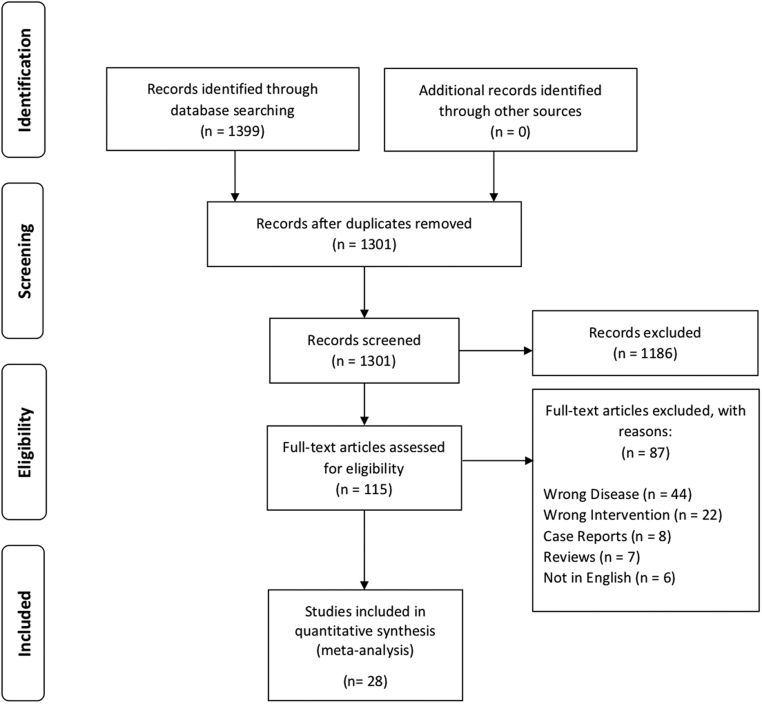
PRISMA flowchart.